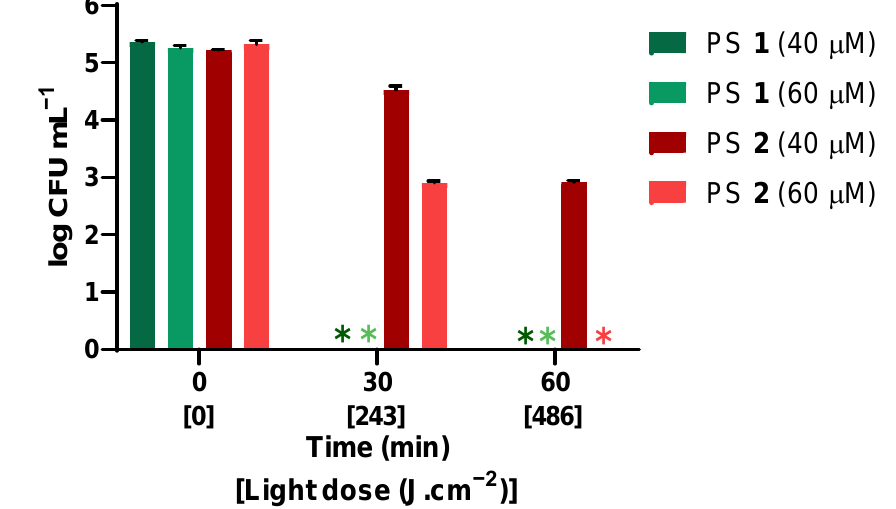
Figure 2. Variation in the concentration of viable conidia of F. oxysporum after 60 min irradiation with artificial white light at a fluence rate of 135 mW·cm −2 (486 J·cm −2 ) in the presence of 20, 40, and 60 µM of PS 1 or PS 2 . LC, light control; DC 1 , dark control with PS 1 at 60 µM; DC 2 , dark control with PS 2 at 60 µM. Values correspond to the average of three independent experiments with replicates. Error bars represent the standard deviation. *, no colonies observed; **, only one assay with three analytic replicates in which the number of colonies was exactly the same, producing a STD value of 0.